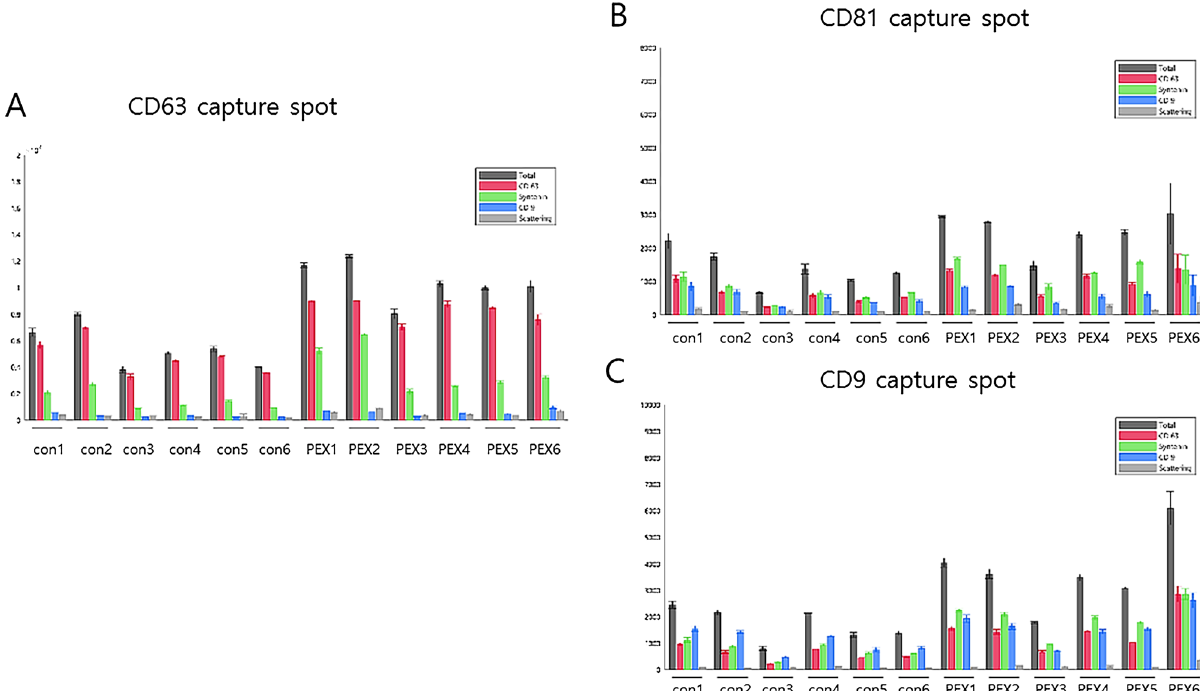
Figure 3. Quantitative exosome particle counts in individual patients The number of exosome particles detected by capture spots ( A ) CD63, ( B ) CD81, and ( C ) CD9 in one to six individual AH samples collected from PEX patients tended to be higher than in one to six control